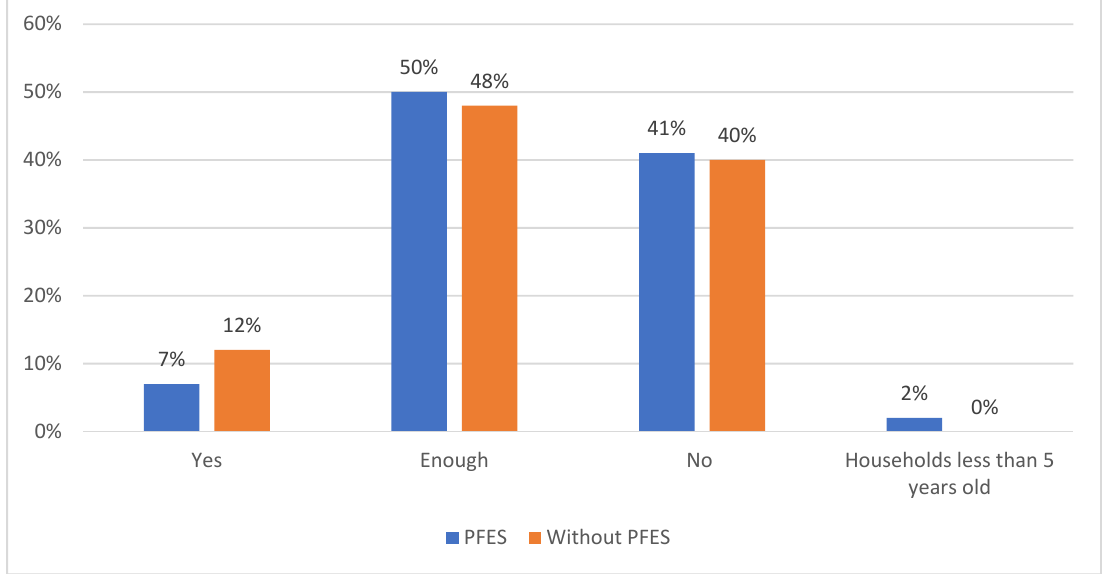
Figure 11. Stakeholder perceptions on whether household income has met family needs (i.e., life security) over the past ten years. Source: compiled by the research team .